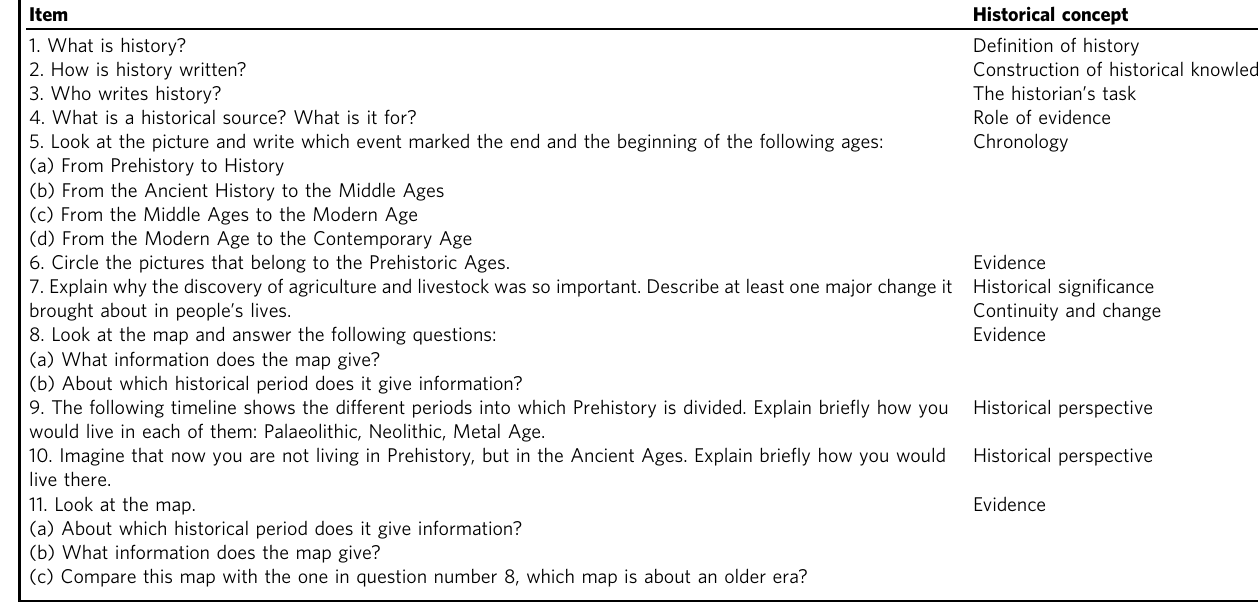
Table 1 Items that comprised the performance test and their respective historical